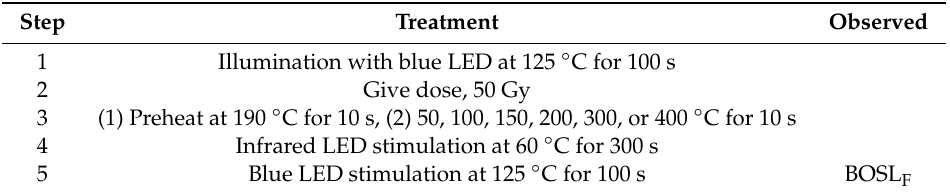
Table 2. Sequence of procedures used to measure OSL sensitivity of quartz and heavy mineral aliquots. BOSL F represents the signal used for sensitivity calculation, which was measured under varied preheat conditions (50–400 ◦ C) and using blue stimulation at 125 ◦